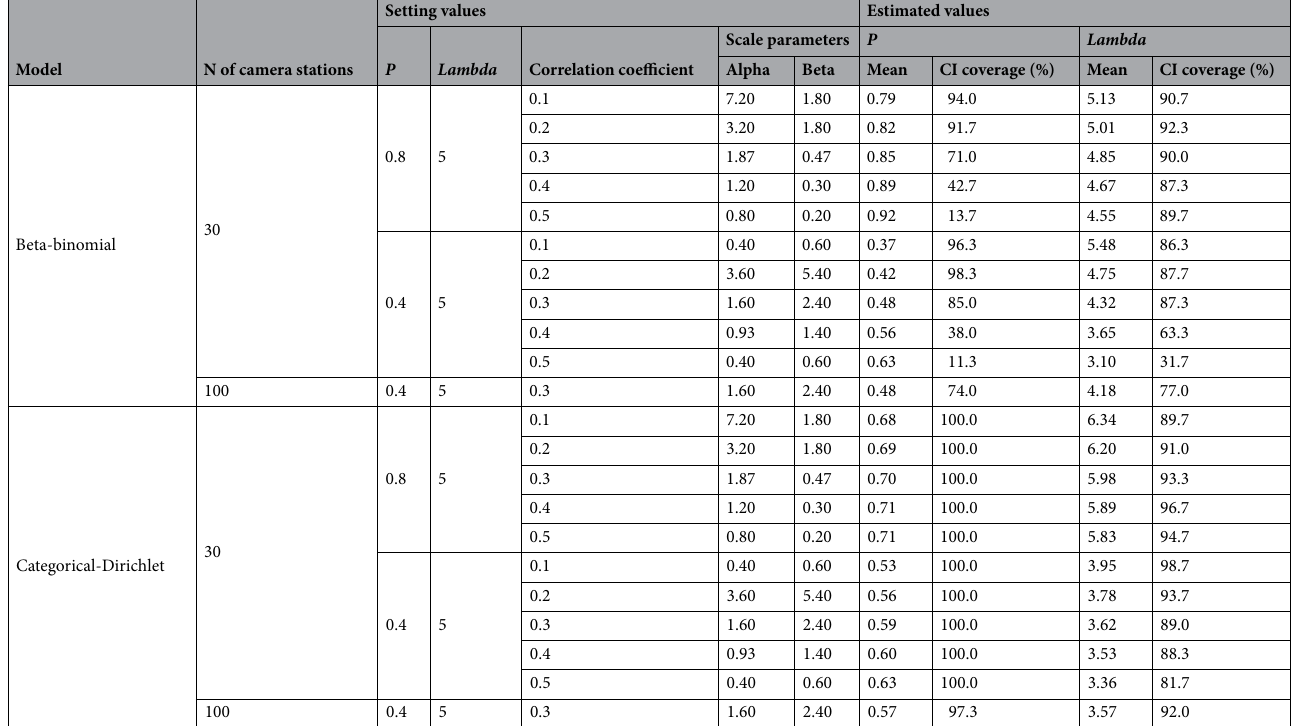
Table 1. Summary of the Monte Carlo simulations to test the reliability of the hierarchical capture-recapture model. The model assuming a beta-binomial distribution and a categorical-Dirichlet distribution as detection processes were tested. The correlation coefficients (= 1/(α + β + 1), ) was varied from 0.1 to 0.5 in 0.1 increments. Results are the mean of estimated median detection probability P and the expected number of animal passes ( lambda ), and their 95% credible interval (CI) coverage of the densities. Parameter estimation of the capture-recapture model was performed using the Markov chain Monte Carlo (MCMC) method, and their variances and credible limits were calculated as the posterior summary.